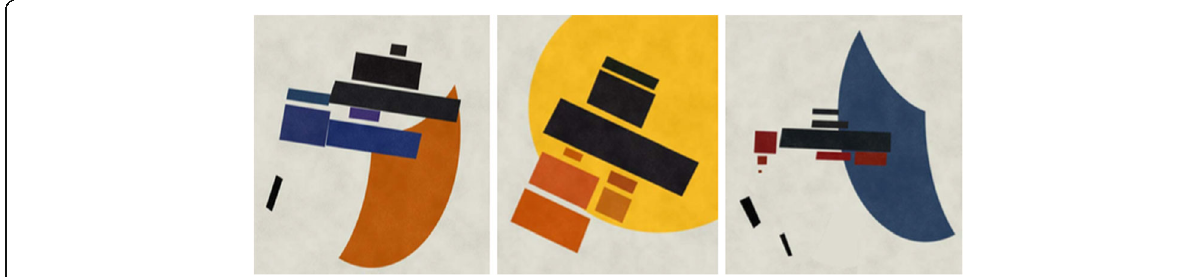
Fig. 21 Computer generated Malevich ’ s “ Mixed Shapes Style ”